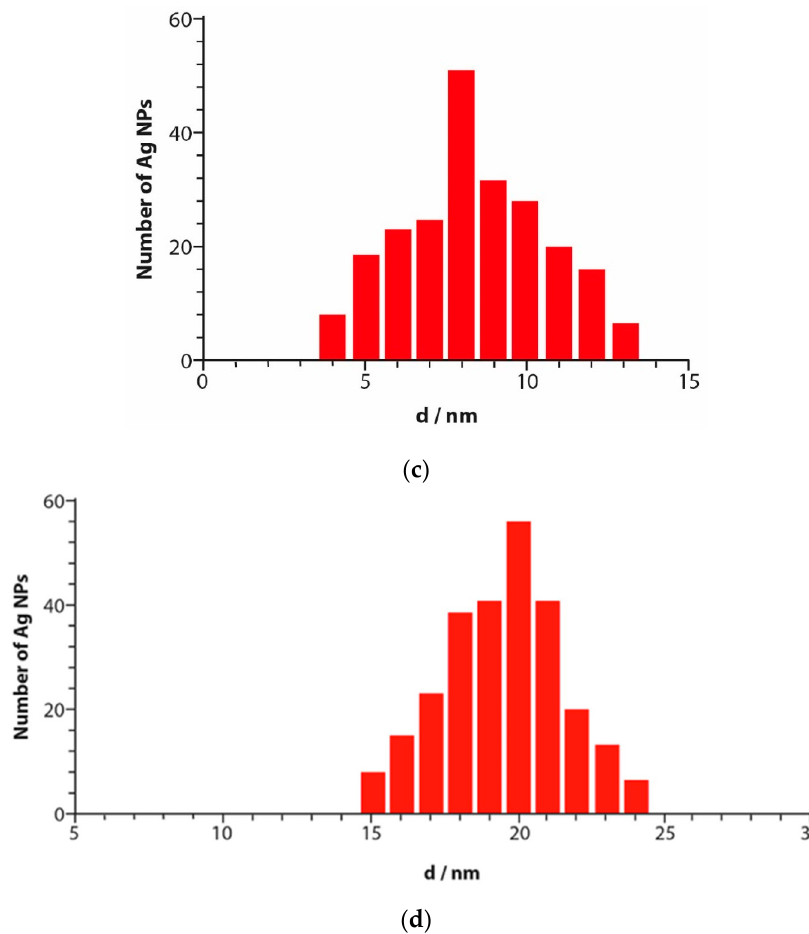
Figure 4. Transmission electron microscopy (TEM) image of a solution of AgNPs obtained with 350 µ moL metal precursor ( a ) and 500 µ moL metal precursor ( b ) deposited on a copper grid, and size distribution of a solution of AgNPs obtained with 350 µ moL metal precursor ( c ) and 500 µ moL metal precursor ( d ). Nanomaterials 2020 , 10 , x FOR PEER REVIEW